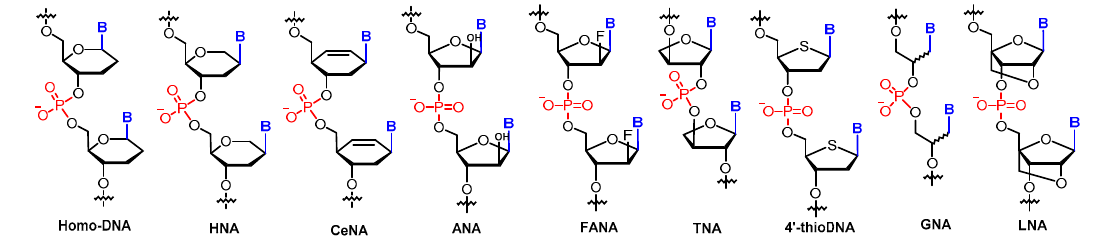
Figure 2. XNAs with artificial backbones.